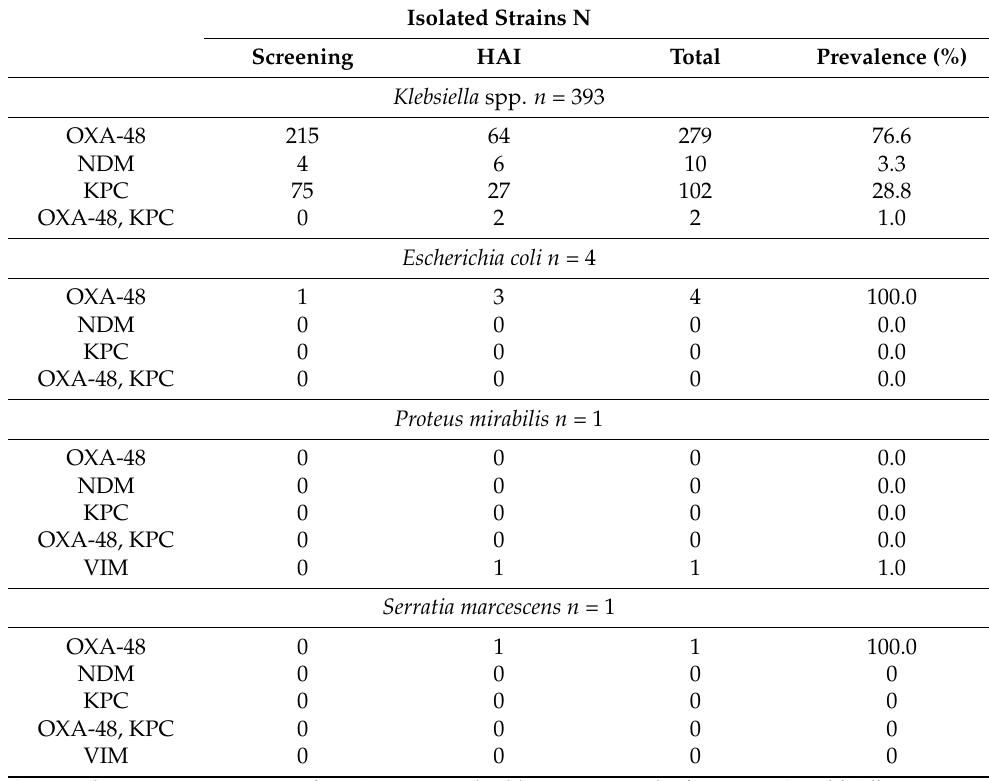
Table 4. Distribution of carbapenemase genotypes by